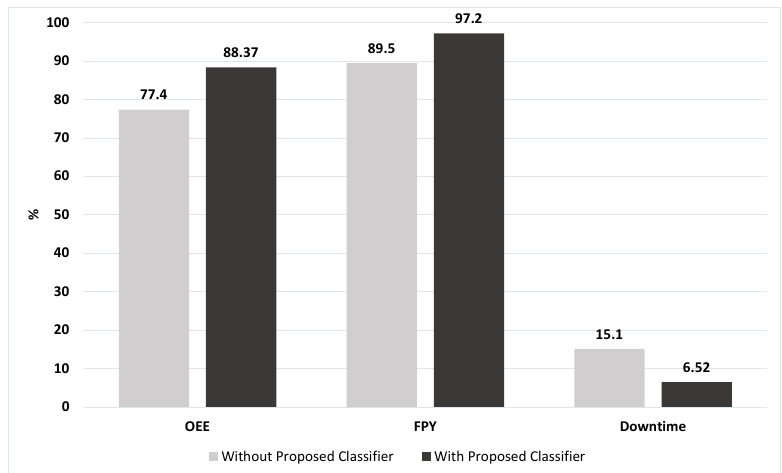
Figure 8. Tederic machine indicators with and without the proposed